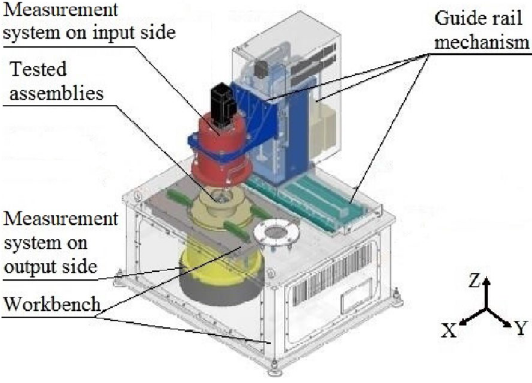
Figure 1. Main structure of the vertical reducer